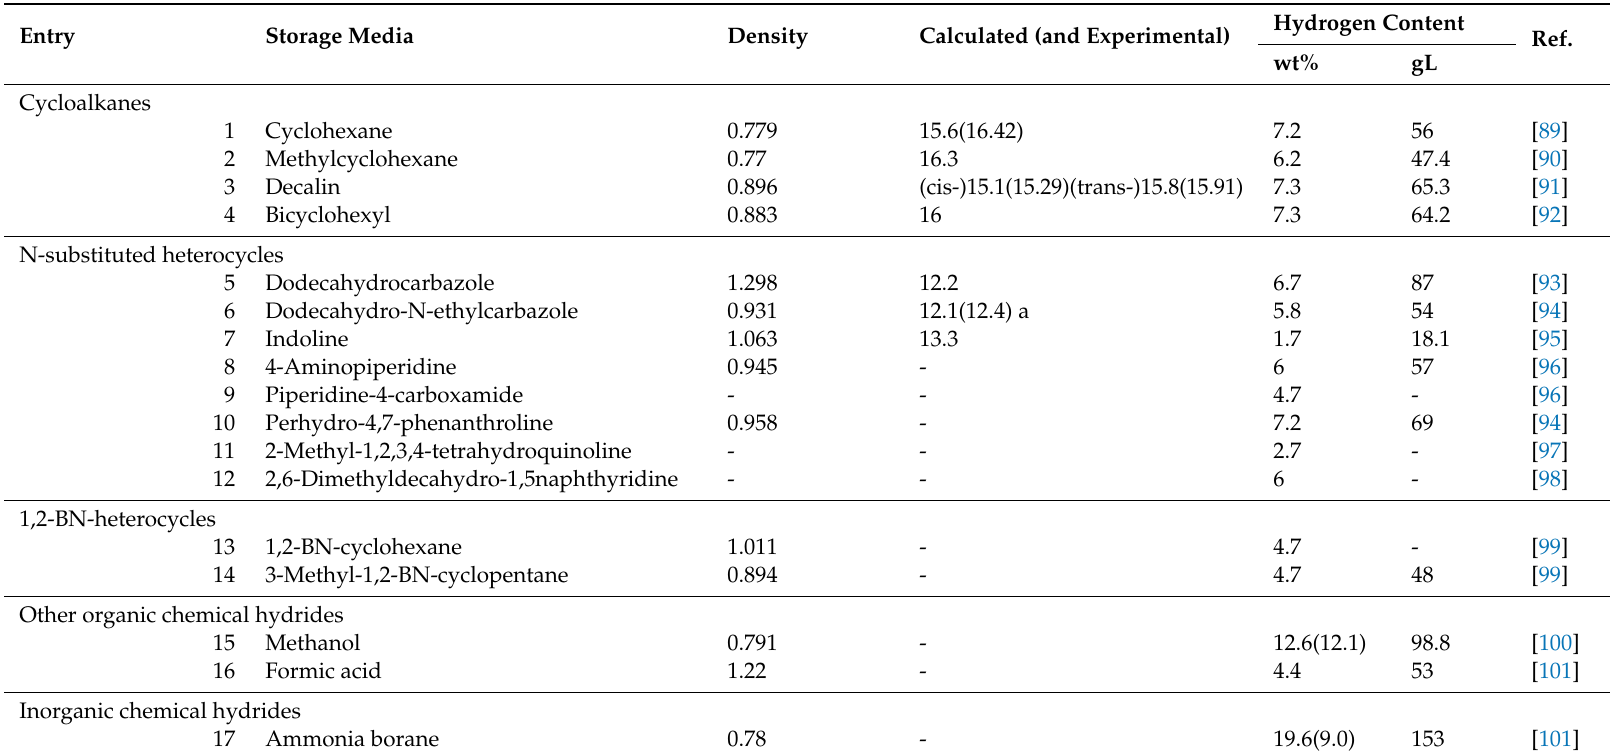
a: Both calculated and experimental data are obtained at 150 ◦